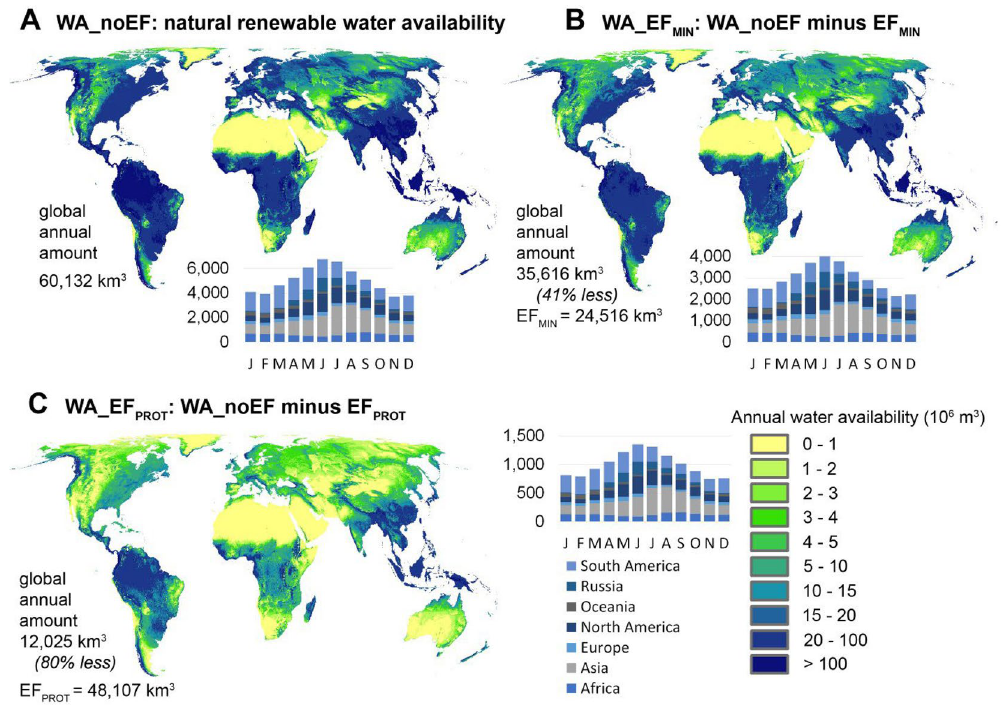
Figure 1. Global renewable water availability in high spatial resolution (0.1 degrees), without and with accounting for Efs. ( A ) map of global annual WA_noEF (in 10 6 m 3 ) and graph with monthly WA_noEF (in km 3 ) per continent; ( B ) map of global annual WA_EF MIN (in 10 6 m 3 ) and graph with monthly WA_EF MIN (in km 3 ) per continent and ( C ) map of global annual WA_EF PROT (in 10 6 m 3 ) and graph with monthly WA_EF PROT (in km 3 ) per continent. Maps generated with ArcMap (Version 10.8, https:// www. esri.